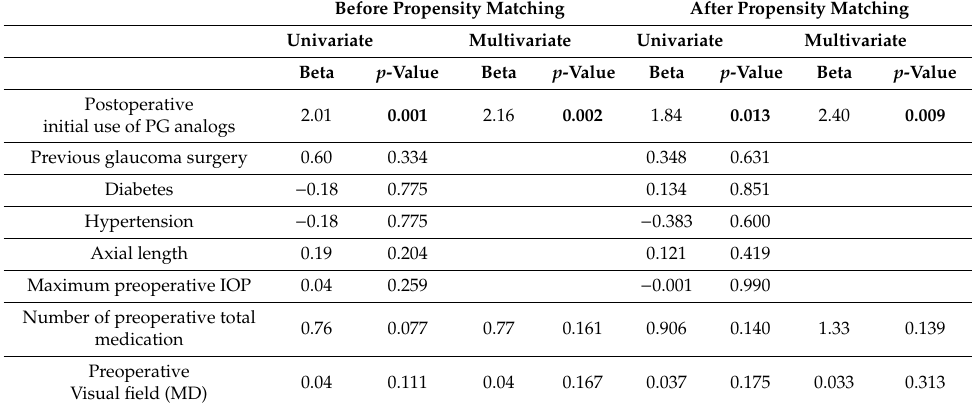
Table 4. Logistic regression analysis of factors associated with surgical failure after Ahmed glaucoma valve (AGV) implantation. Before Propensity Matching After Propensity